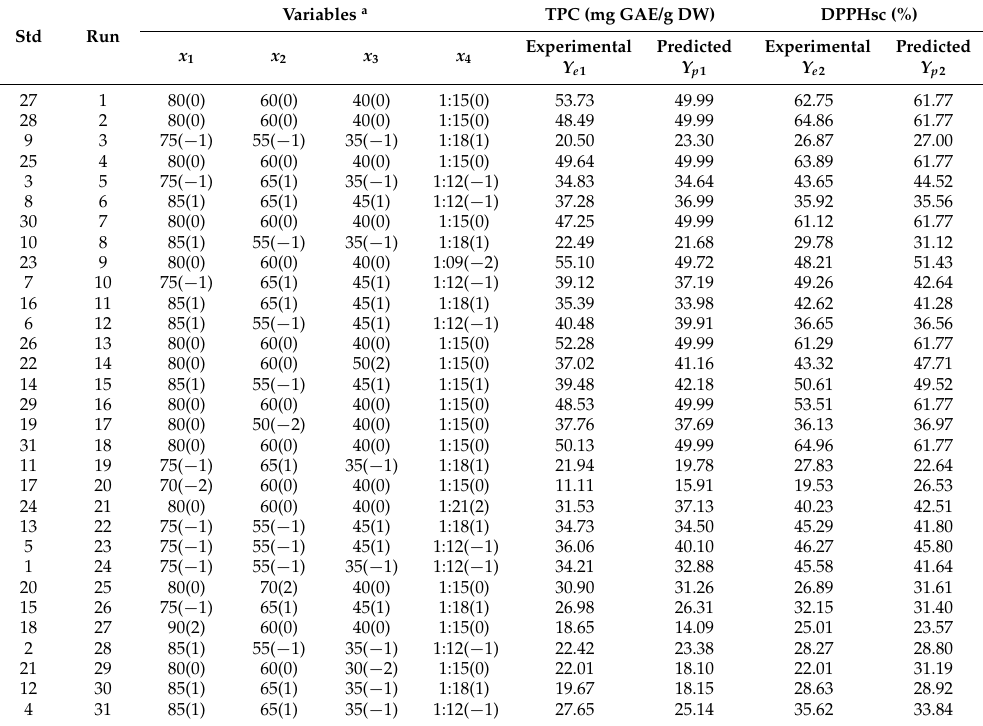
Table 2. Central composite design (CCD) arrangement for the KSP extraction with respective coded factors, variable levels, responses and predicted values for total phenolic content (TPC) and DPPH scavenging capacities (DPPHsc) (number of samples n = 3).